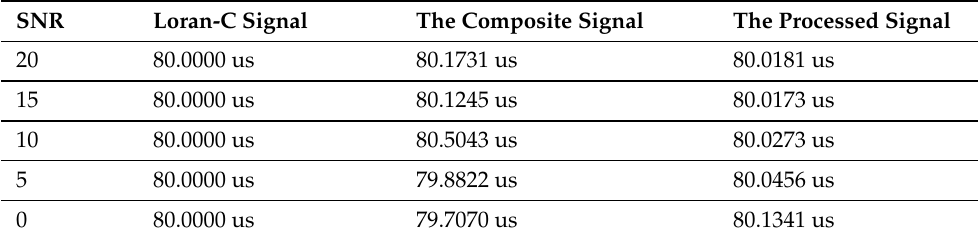
Figure 6. Results of separation by the proposed method (white noise: 15 dB). ( a ) Simulated synthetic signal. ( b ) Spectrum of simulated synthetic signal. ( c ) Separated Loran-C signals. ( d ) The spectrum of separated Loran-C signal. ( e ) Separated CWI. ( f ) The spectrum of separated CWI. Table 2. Comparison of the third zero-crossing